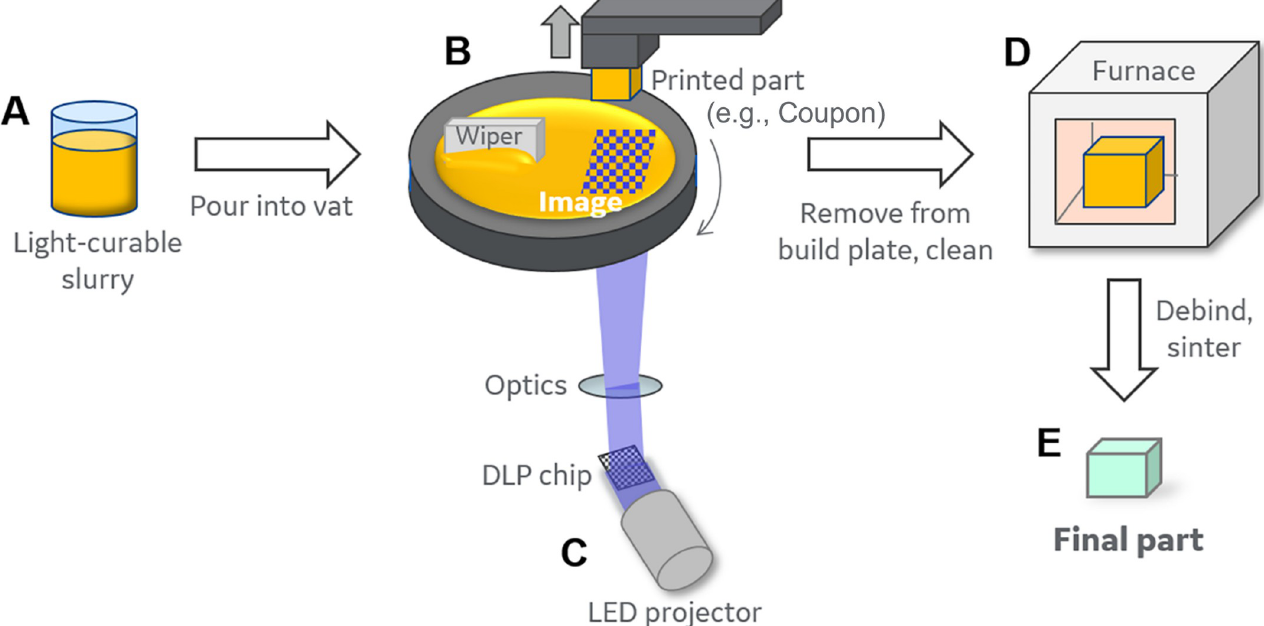
Fig 1. Illustration of DLP process. (A) The DLP process starts with a light curable resin and a powder, which are combined to make a photocurable slurry. We utilized a premixed hydroxyapatite photocurable slurry. (B) Slurry is poured into the vat where the (C) light is projected from below onto the build plate, curing one layer at a time of the part (e.g., coupons). (D) The printed part (coupon) is removed from the build plate and cleaned, then placed in a furnace where the light curable resin is burned out and the ceramic densifies, (E) creating the final part (coupon).